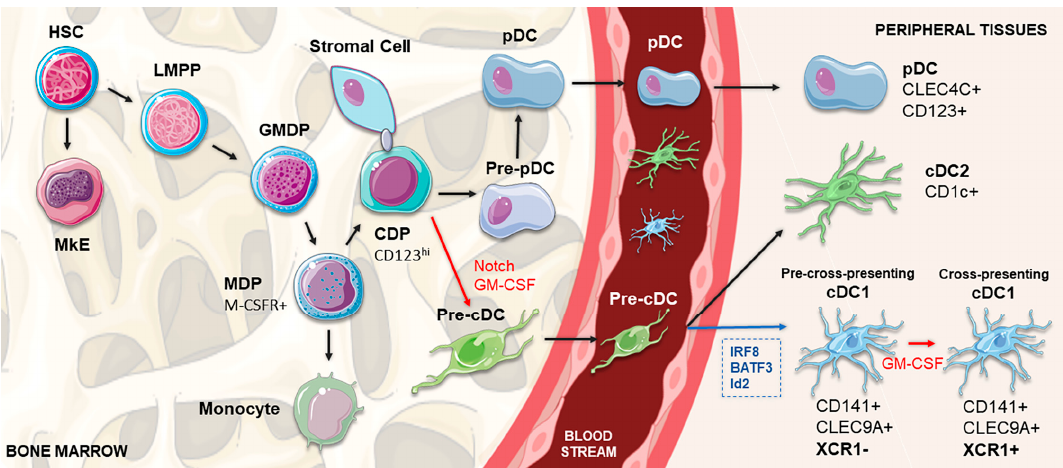
Figure 1. Schematic representation of cDC1 DC development. In the bone marrow, HSC gives rise to the LMPP, which settles at the apex of all myeloid and lymphoid lineages and is separated from the MkE. GMDP derives from the LMPP and produces the MDP (expressing M-CSFR), which further differentiates into the CDP, capable of generating the main DC subsets: pDCs, cDC1 and cDC2. pDCs terminally differentiate in the bone marrow, whereas pre-cDC migrate through the blood to lymphoid and non-lymphoid tissues, where they produce cDC1 and cDC2 subsets. Determining the differentiation pathway, Notch-dependent interactions of CDPs with stromal cells, in cooperation with GM-CSF, are crucial for the commitment to the cDC1 lineage, separating their pathway from pDCs. In peripheral tissues, the differentiation into CD141 + cDC1 is controlled by transcription factors, such as IRF8, Batf3 and Id2 (shown in blue). After engagement with the CD141 + pathway, the existence of a two-staged differentiation process of cDC1 populations is proposed, in which XCR1-negative cDC1s under the influence of GM-CSF (shown in red) acquire the expression of XCR1, representing the shift between a pre-cross-presentation phase and a subsequential cross-presenting stage. cDC, conventional dendritic cell; CDP, common DC precursor; DC, dendritic cell; GM-CSF, granulocyte-macrophage colony-stimulating factor; GMDP, granulocyte macrophage DC progenitor; HSC, hematopoietic stem cell; LMPP, lymphoid-primed multipotent progenitor; M-CSFR, macrophage colony-stimulating factor receptor; MDP, macrophage DC precursor; MkE, megakaryocyte and erythroid potential; pDC, plasmacytoid dendritic cell.